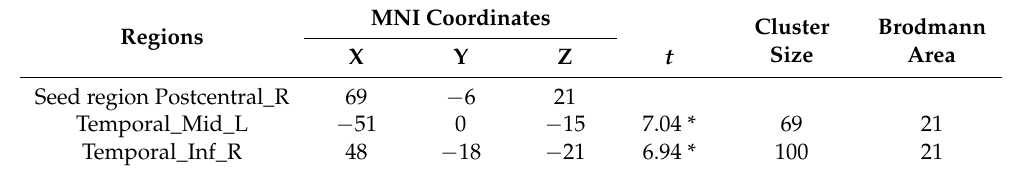
were located in the Brodmann 21 region, functional connectivity was significantly en-